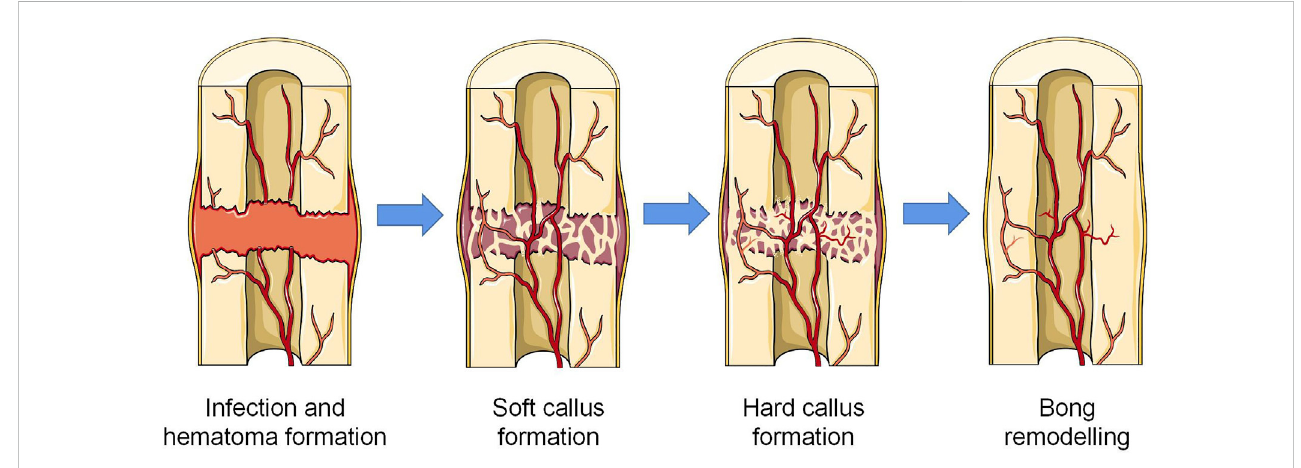
FIGURE 1 Four stages of endochondral osteogenesis (The Figure was partly generated using Servier Medical Art, provided by Servier, licensed under a Creative Commons Attribution 3.0 unported